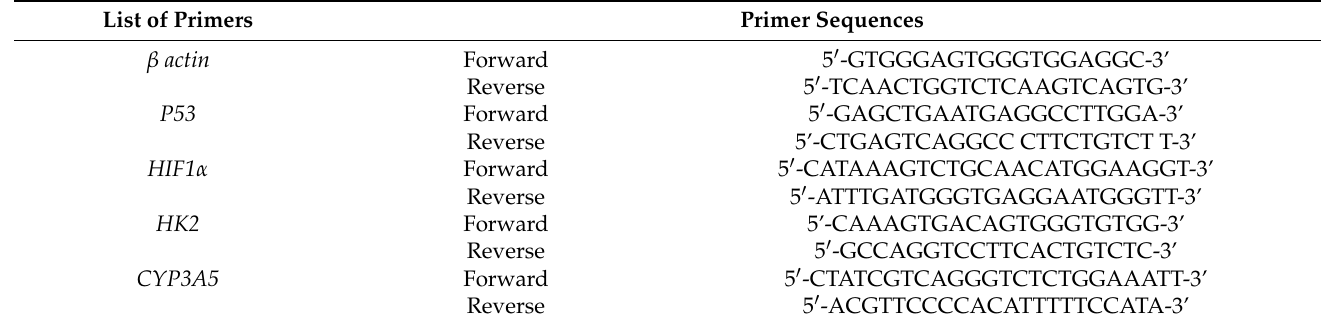
Table 2. List of primer